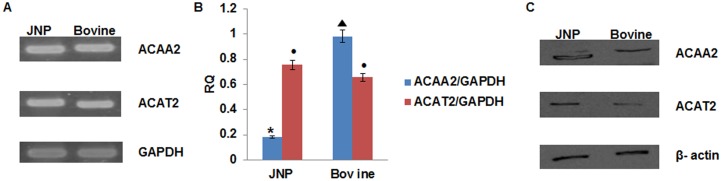
Expression analysis of mRNA and protein levels of ACAA2 and ACAT2 in swine and bovine species.a) Expression of mRNA after RT-PCR using 1% agarose gel. b) Relative quantitative expression of ACAA2 and ACAT2 genes; bars with different superscripts show significantly different expression in the two species (P<0.05). c) Representative blot expressions of ACAA2, ACAT2, and β-actin proteins obtained by western blotting.